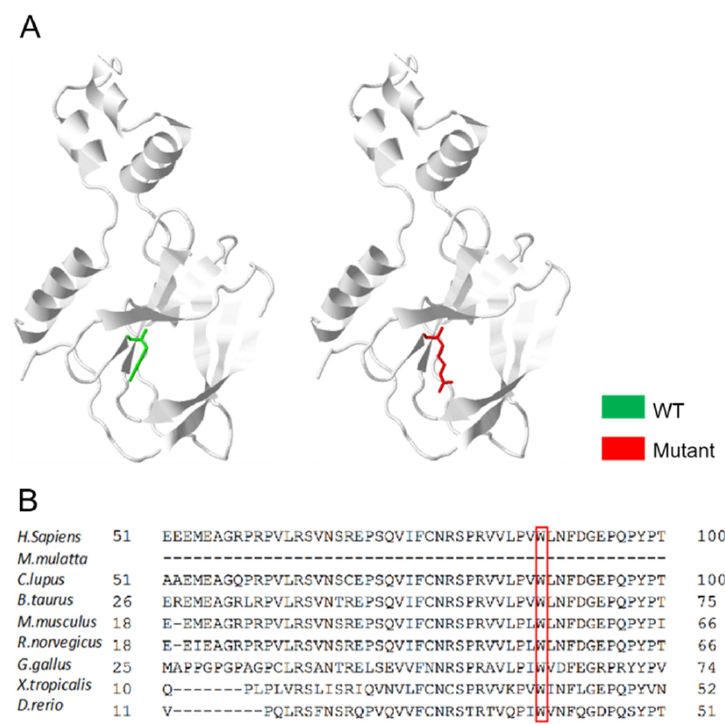
Figure 3. In silico analysis of pVHL. ( A ) Missense3D does not predict a structural change introduced by a TRP (wild type) > ARG (mutant) substitution; ( B ) multiple sequence alignment of the mutant residue (p.Trp88Arg) in wild-type VHL protein of several species. (The red recktangle refers to the conserved amino among different species).